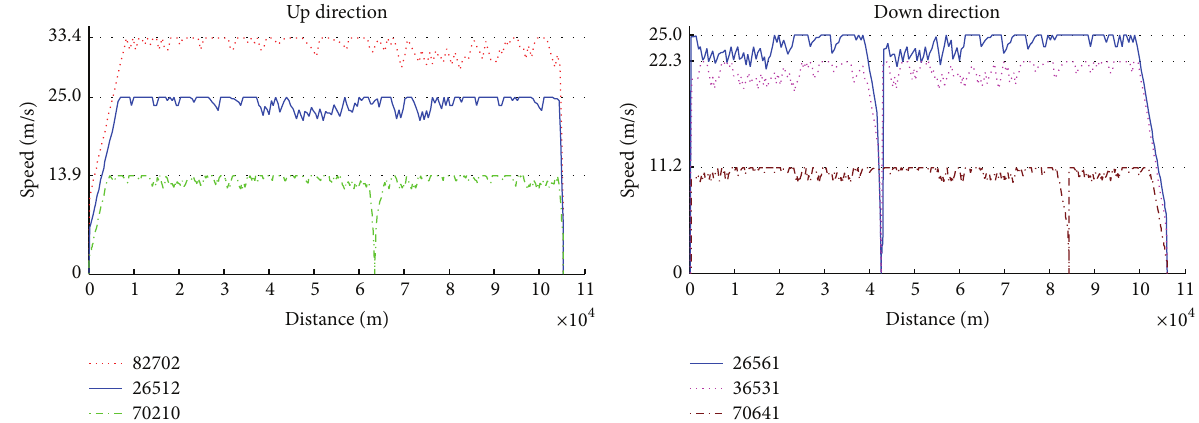
Figure 17: Train speed-distance curve (NCBS: blocking sections 2 ∼ 4 in the